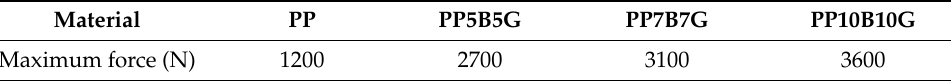
Table 3. Maximum tensile force within